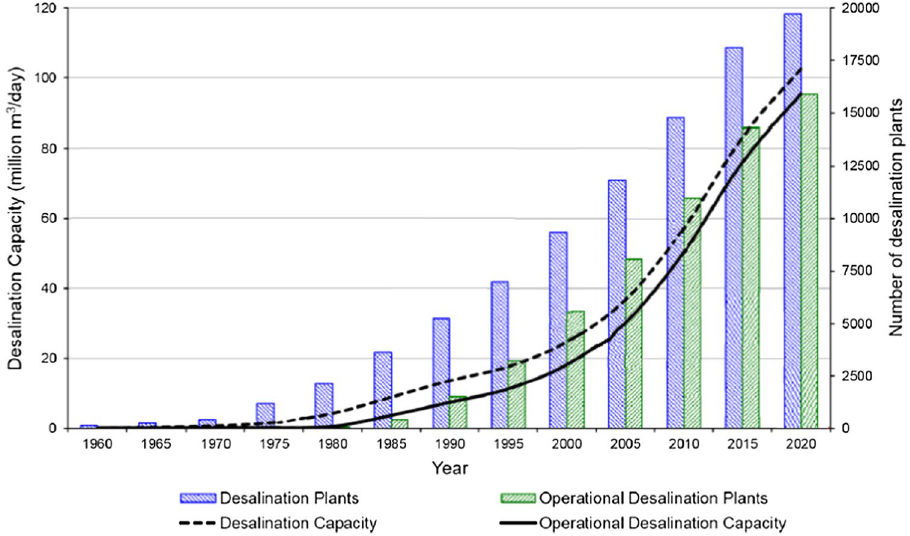
Fig. 7 Noticeable increase in the number of desalination plants and desalination capacity over the last two decades (Jones et al.